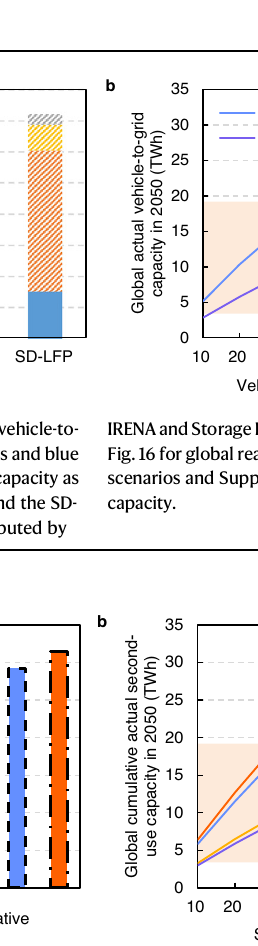
second-use utilisation rate on cumulative actual second-use capacity and a com- parison to storage demand in 2050 (orange shading). See Supplementary Figs. 22 – 25 for regional actual second-use capacity.